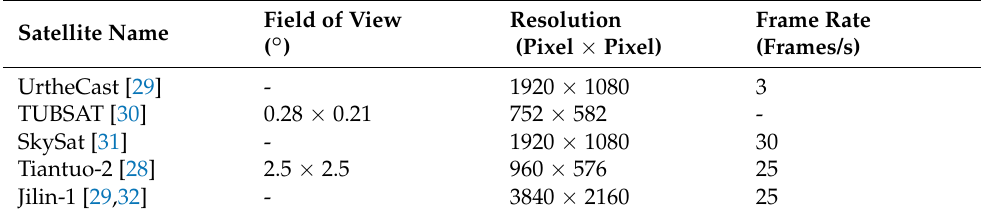
Table 1. Typical video satellites and key parameters.